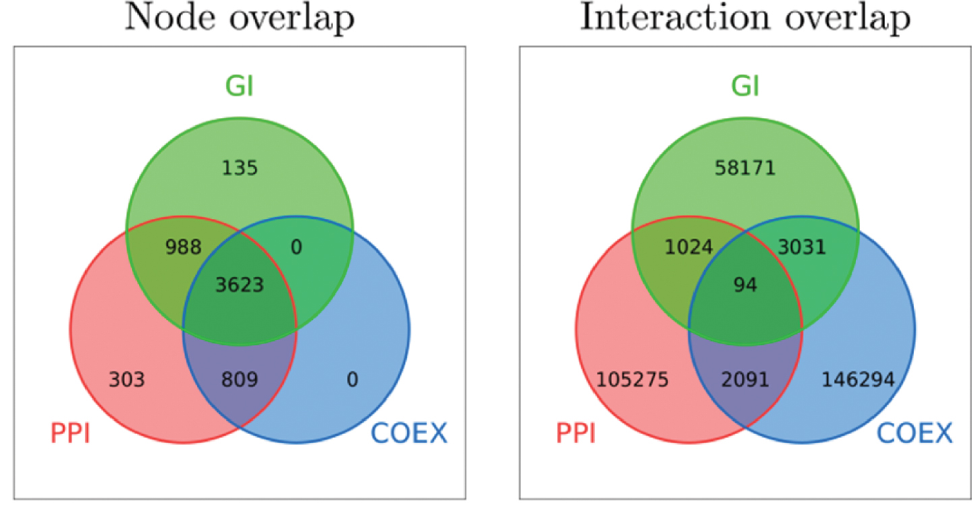
Figure 5: Overlaps between molecular interaction datasets. While molecular interaction datasets share most of their genes (nodes), most of the interactions (edges) are unique to each